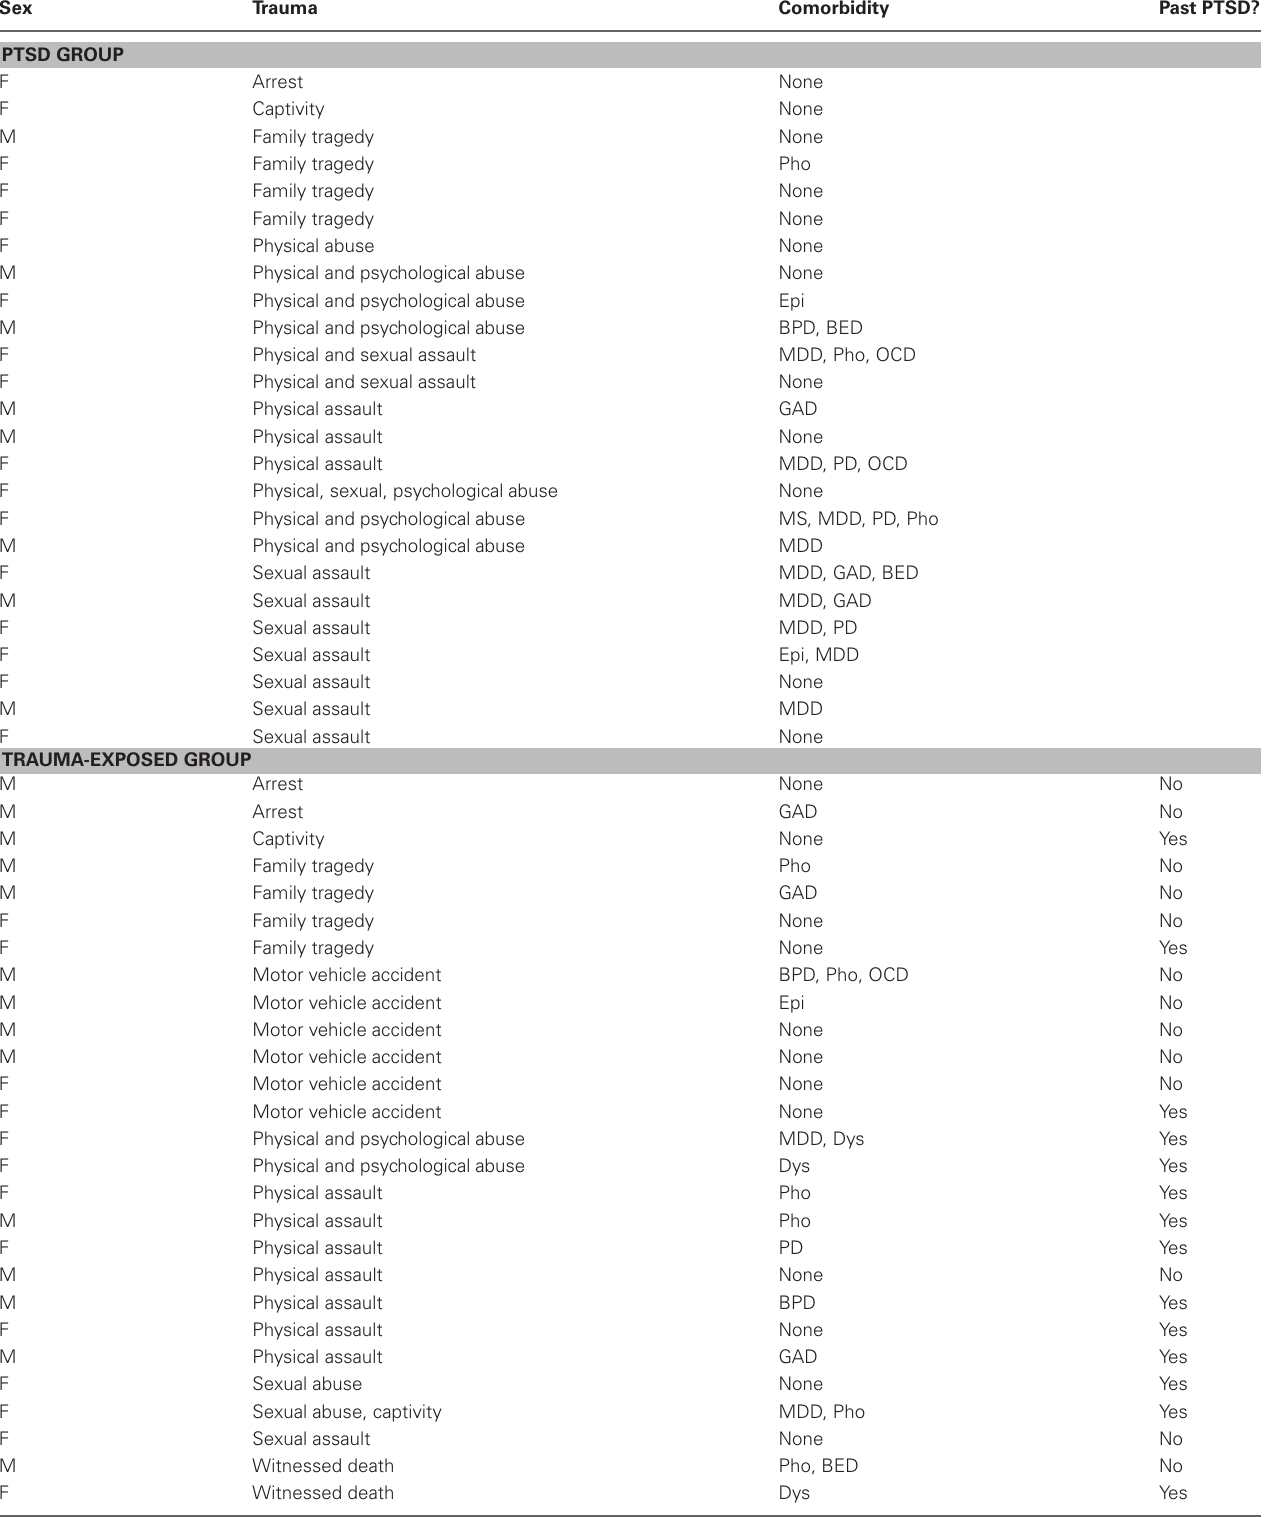
Table 1 | Type of trauma and comorbidities for the PTSD and the Trauma-Exposed Groups. Sex Trauma Comorbidity Past